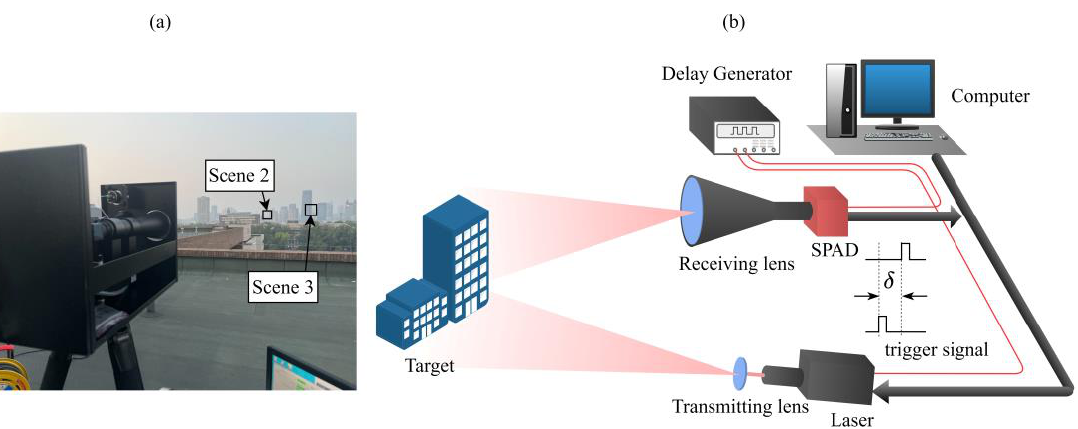
Figure 3. ( a ) A photograph of our experimental dithered single-photon lidar. ( b ) The system dia-